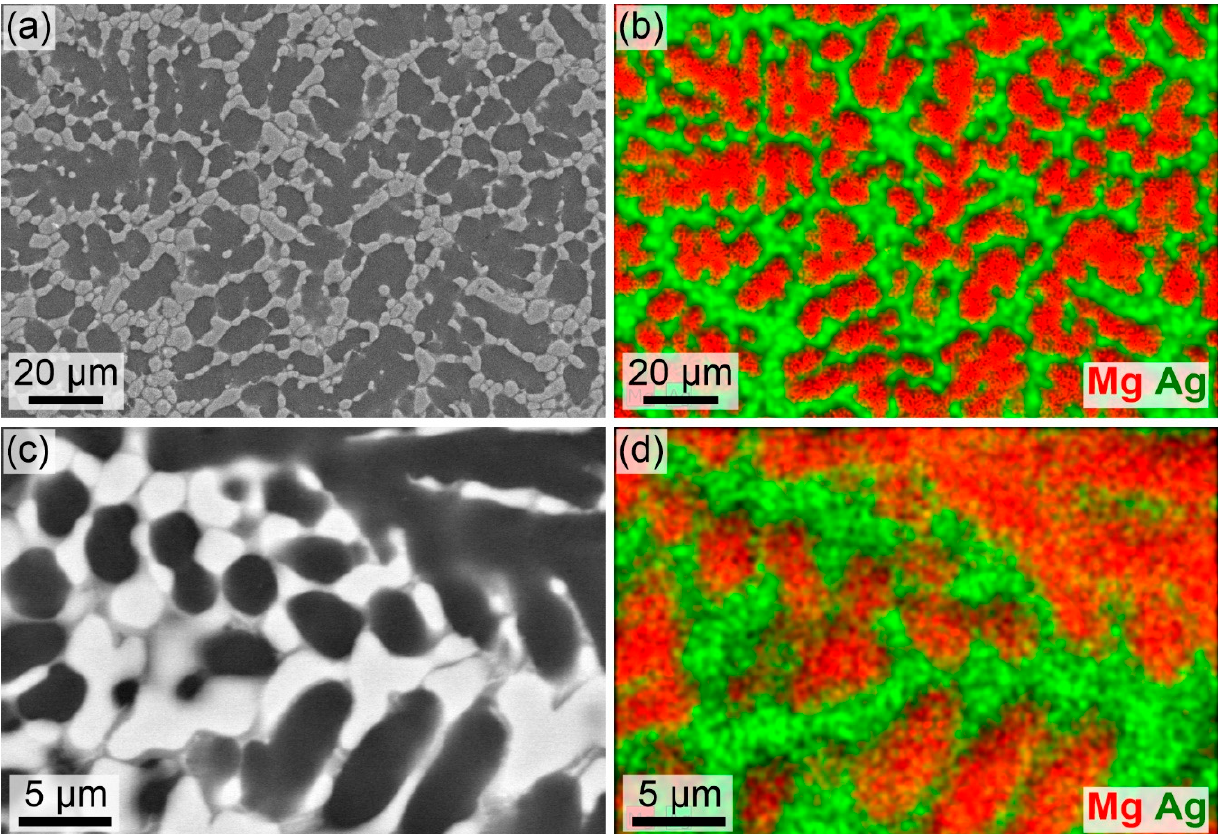
Figure 4. Secondary electron microscopic (SEM) images and energy X-ray dispersive (EDX) maps of the Mg 67 Ag 33 microstructure: ( a ) SEM image and ( b ) corresponding EDX map illustrate the overall microstructure. ( c ) SEM image at higher magnification and ( d ) respective EDX map of the interdendritic phases.